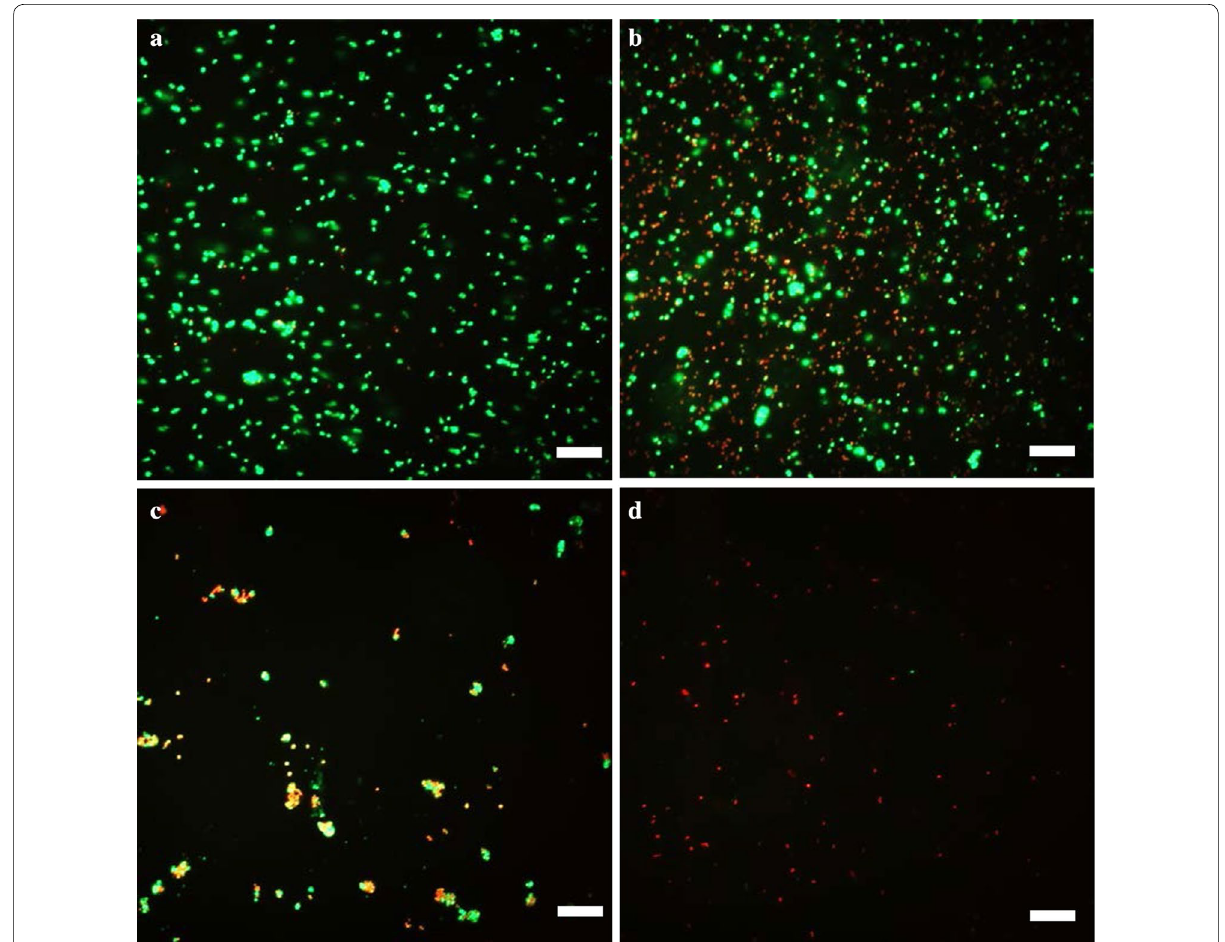
Fig. 5 Live/dead staining of S. aureus biofilms after treatment with CHX, DC, or concurrent treatment. a Without treatment. b Treatment with 20 μg/ mL CHX. c Treatment with 28 μA/cm 2 DC. d Concurrent treatment with 20 μg/mL CHX and 28 μA/cm 2 DC. Bar